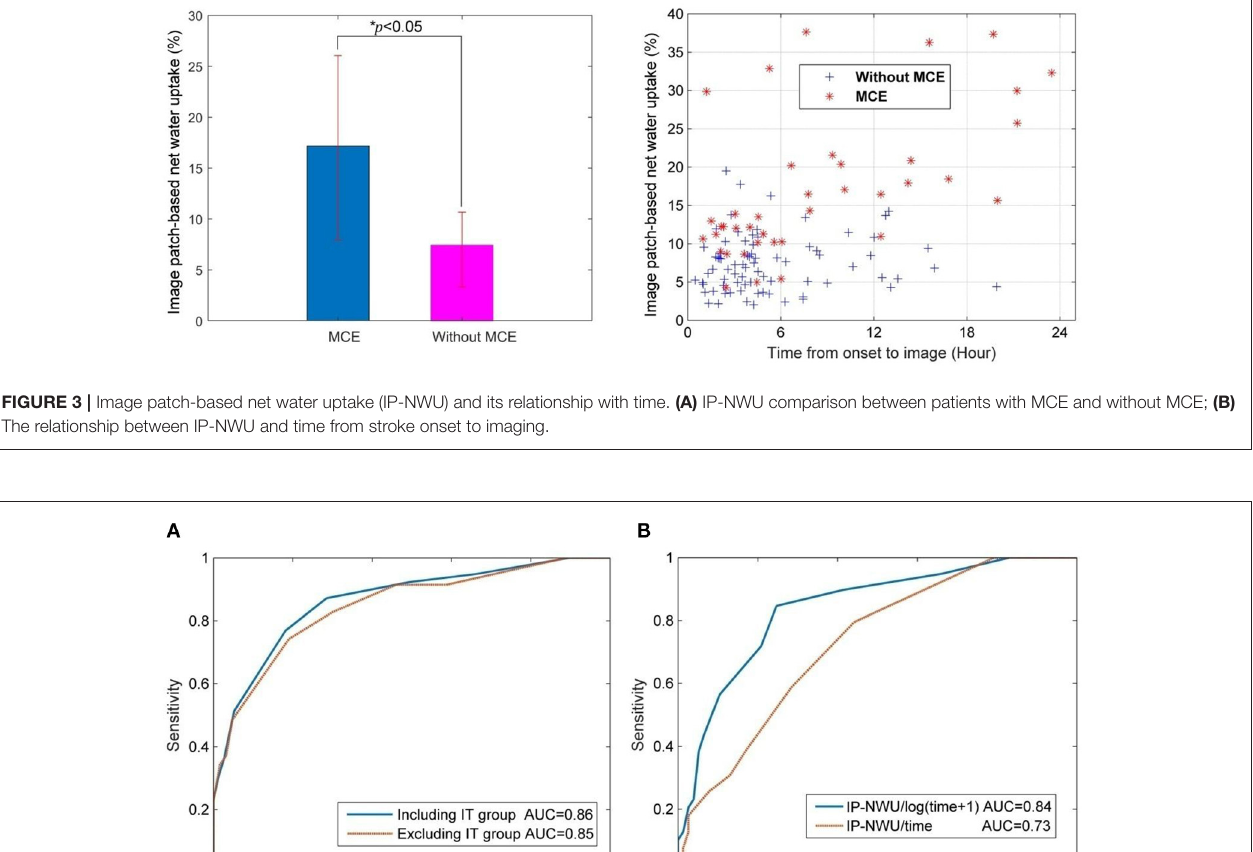
TABLE 1 | Characteristics of patients with a middle cerebral artery ischemic stroke. Characteristic Patient with MCE, Demographics